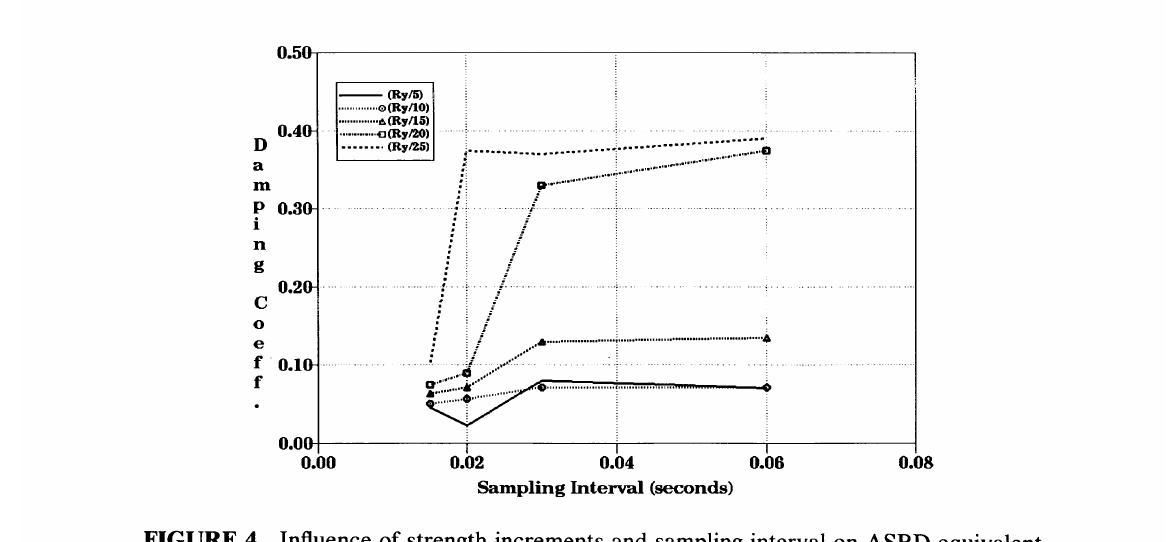
FIGURE 4 Influence of strength increments and sampling interval on ASBD equivalent damping